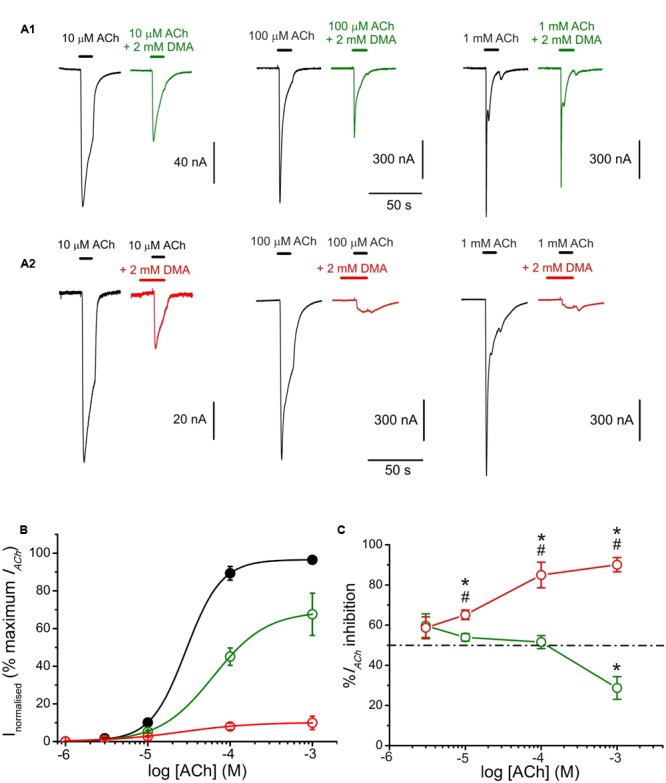
2,6-Dimethylaniline effects on ACh concentration-IACh amplitude relationship. (A)
IACh recordings evoked by applying, successively, ACh at increasing concentrations (10, 100 μM, and 1 mM) either alone (black traces) or co-applied with 2 mM DMA either directly (A1, green recordings) or after being pre-applied for 12 s (A2, red recordings). (B) Averaged ACh concentration-IACh amplitude curves obtained following the experimental protocol shown in (A). Black filled circles are for ACh alone (n = 10–23, N = 4–5), green open circles for co-application of ACh plus 2 mM DMA (n = 4–5, N = 3) and red open circles when ACh and DMA co-application was preceded by 12 s of 2 mM DMA pre-application (n = 4–7, N = 2–4). All data were normalized to the maximal IACh elicited by ACh alone and fitted to the Hill equation (continuous lines). (C) Plot showing the percentage of IACh inhibition at different ACh concentrations when ACh was directly co-applied with 2 mM DMA (open green circles and solid line; n = 4–28, N = 4–10), or when ACh and 2 mM DMA co-application was preceded by 12 s DMA pre-application (open red circles; n = 5–15, N = 4–9). Asterisks indicate significant differences (p < 0.05, ANOVA and Bonferroni t-test) respect to the IACh blockade caused by solely co-applying 10 μM ACh and 2 mM DMA; pound signs indicate significant differences (t-test), for each ACh dose, between the IACh blockade caused by direct co-application of ACh with DMA and when it was preceded by a 12 s DMA application. The dashed line indicates 50% inhibition. Note the reduction of IACh inhibition when DMA was co-applied with high ACh concentrations (1 mM) and the strong IACh blockade when DMA was pre-applied before its co-application with high ACh concentrations.